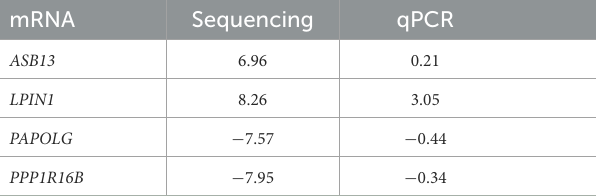
TABLE 4 qPCR results verified the differentially expressed mRNAs between first-episode, drug-naive MDD patients and healthy controls. mRNA Sequencing qPCR ASB13 6.96 0.21 LPIN1 8.26